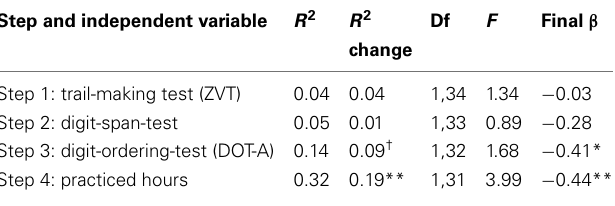
Table 2 | Hierarchical regression